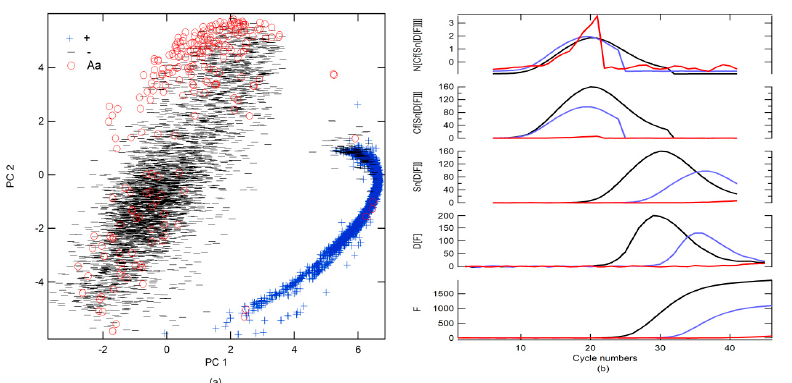
Figure 4. ( a ) Score plots of PC 2 vs. PC 1 for real-time RT-PCR curves for the diagnosis of SARS-CoV- 2 and their classification based on the S-Data-model; ( b ) scheme of the best